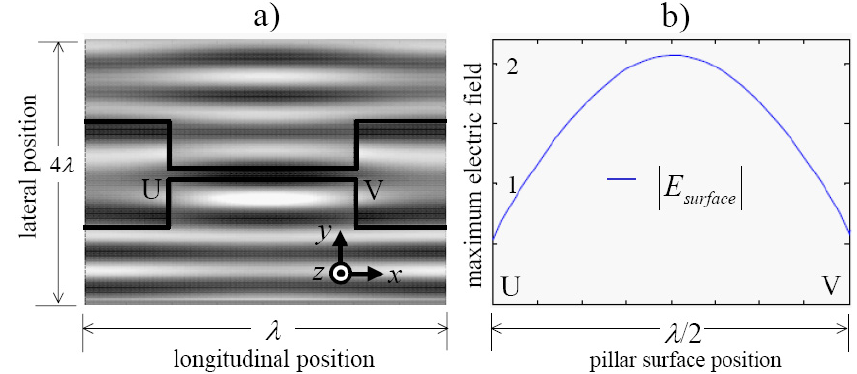
FIG. 2. (Color) (a) Gray-scale map of a snapshot of the electric field produced by an incident cw plane wave in one grating segment of the accelerator structure. The black line indicates the material-to-vacuum interface. Points U and V indicate the corners of the grating (cid:4) 1 and is launched from the bottom and pillar, which in this example has a length of 0 : 9 (cid:3) . The plane wave has an amplitude E 0 travels upwards. Notice the phase shift between the narrow and the wide gap regions in the vacuum channel and the reconstruction of the plane wave in the upper region. (b) The maximum surface field between points U and